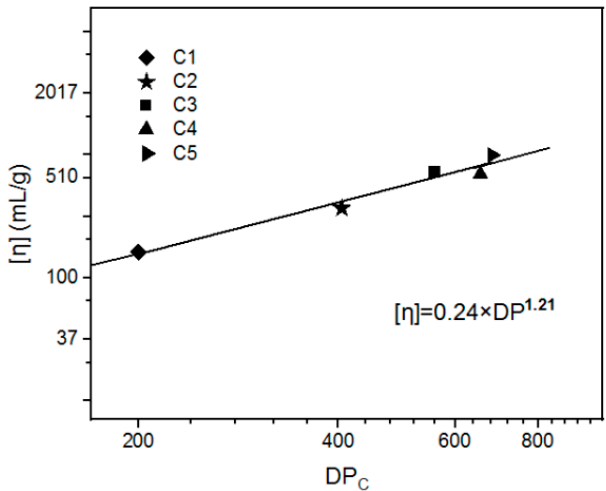
Figure 2. The relationship between the [ η ] and the DP C of cellulose.